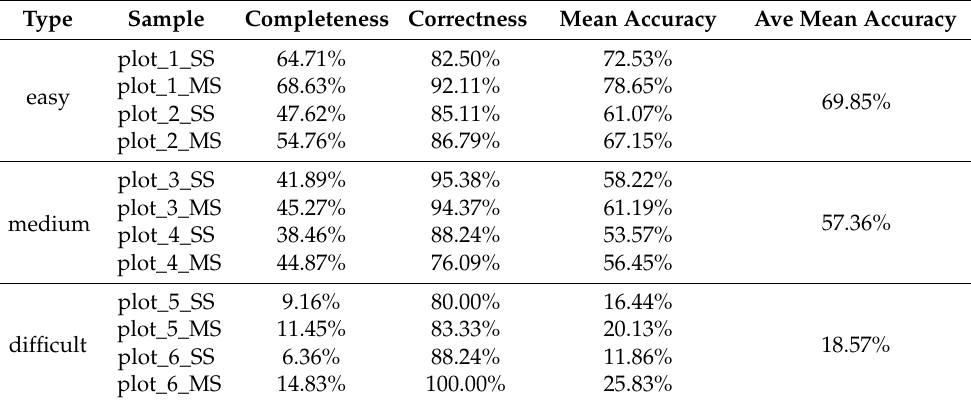
Table 4. Three accuracy indicators calculation results of the proposed method towards the six plots. In each plot, both single-scan (SS) and multi-scan (MS) modes are included.